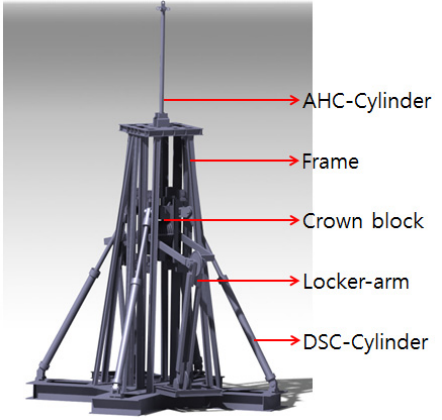
Figure 3. Three-dimensional model of the heave compensator.